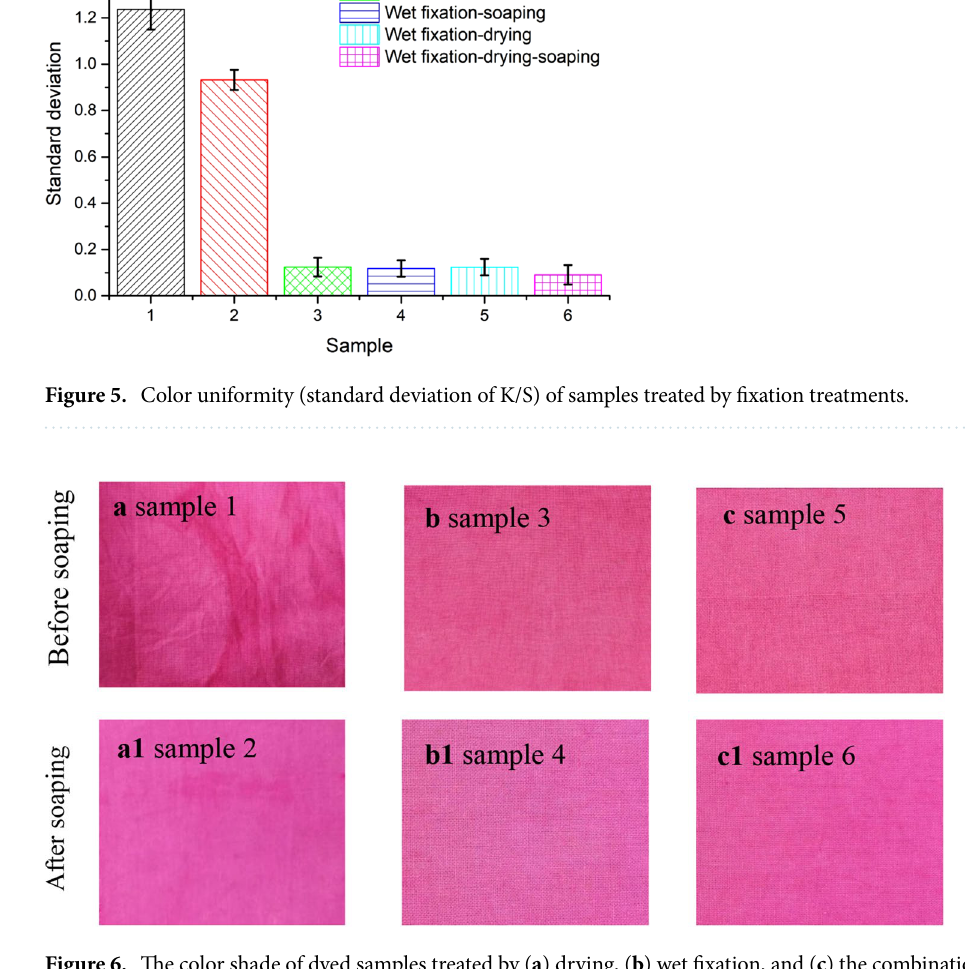
Figure 6. The color shade of dyed samples treated by ( a ) drying, ( b ) wet fixation, and ( c ) the combination of wet fixation and drying before and after soaping.